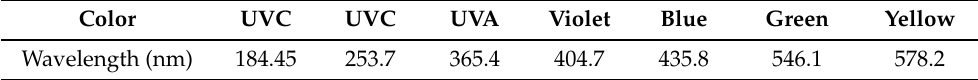
Table 1. Emission lines of the vapor mercury